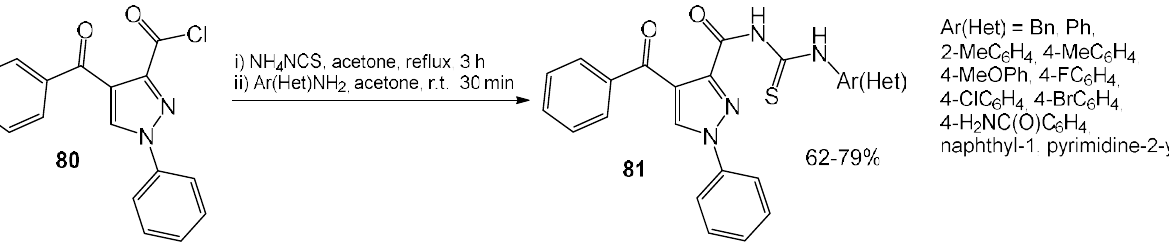
Fig. 23. “One-pot” synthesis of 4-benzoyl-1-phenyl- N- (aryl-(hetaryl-)carbamothioyl)-1 H -pyrazole-3-carboxamides promising antitumor